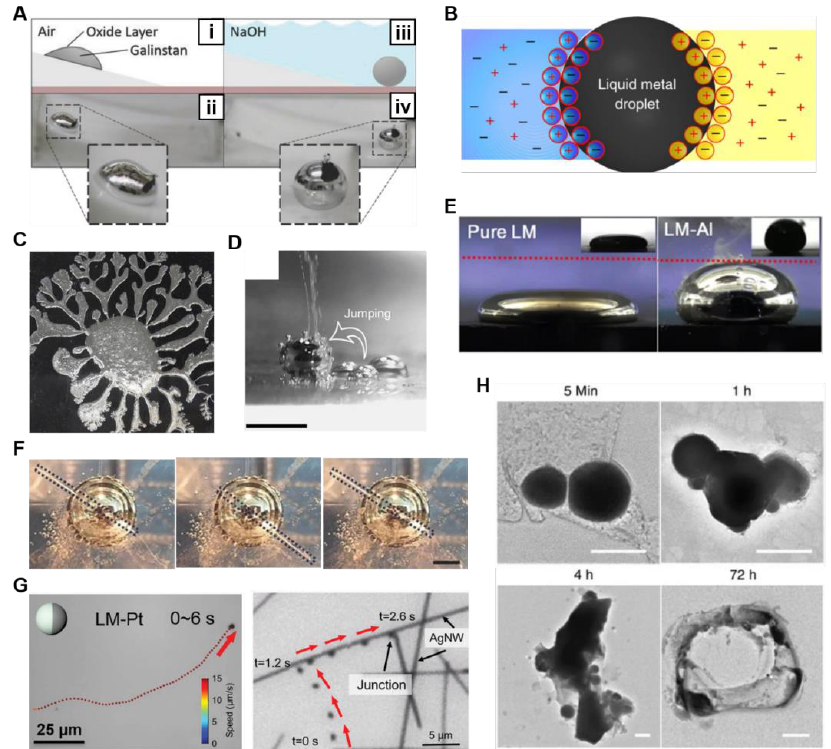
Figure 7. Chemically induced responses. ( A ) The different morphology of liquid metal (LM) droplet in air and NaOH solution, respectively. Reprinted with permission from ref. [114]. Copyright